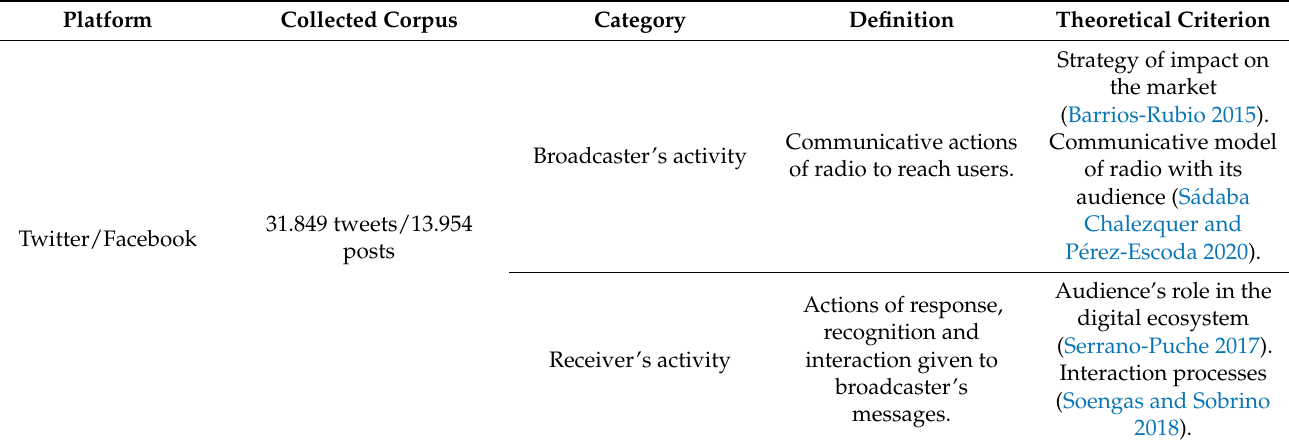
Table 2. Categories from which the research analysis is